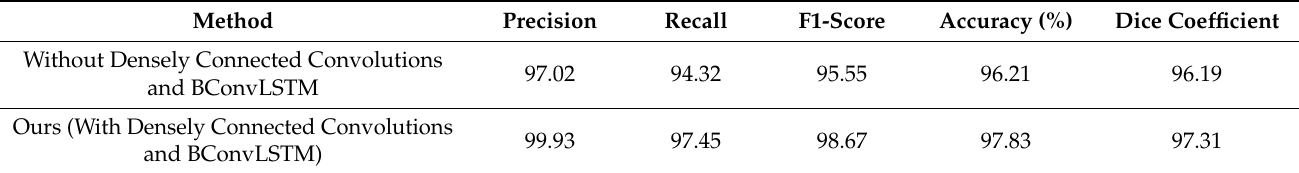
Table 3. Impact of using densely connected convolutions and BConvLSTM on system performance.